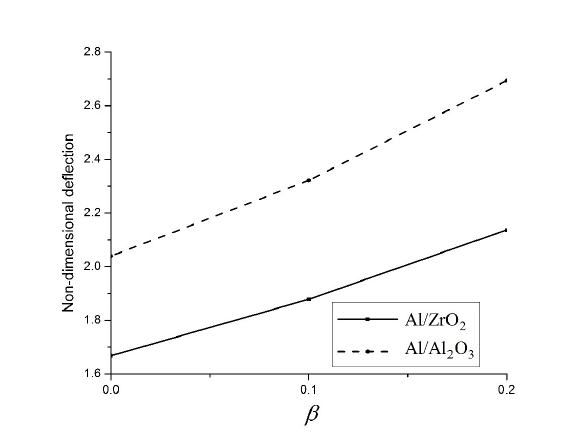
Figure 5: Variation of non-dimensional deflection of FGM porous conoidal shell under uniform